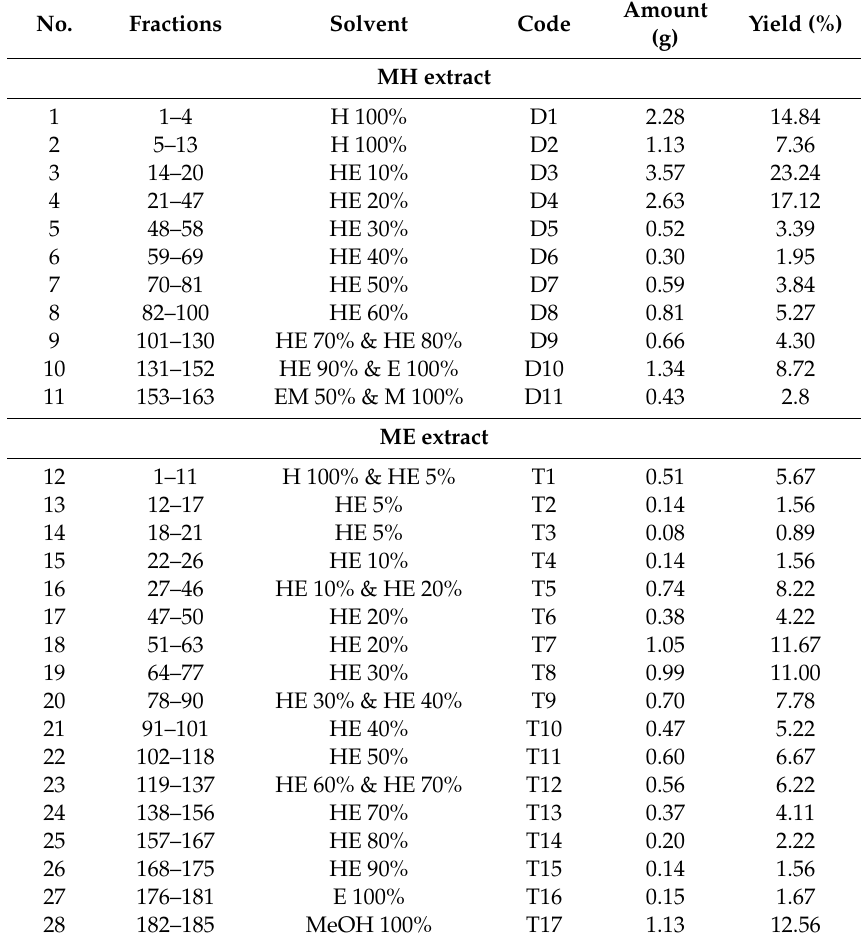
Table 3. Column chromatography procedure of MH and ME extracts and yields of obtained fractions.